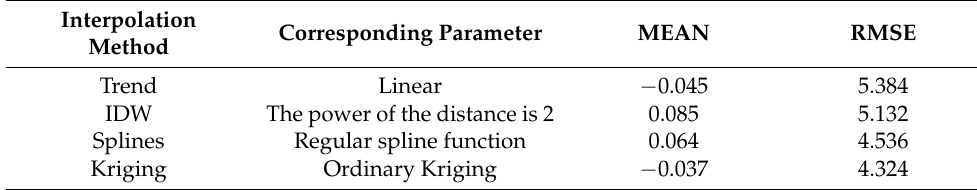
Table 1. Comparison of four common interpolation methods in ArcGIS.